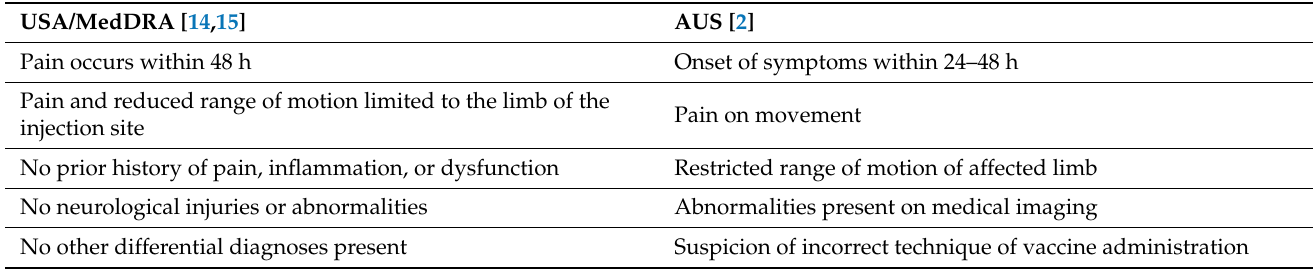
Table 1. SIRVA diagnostic